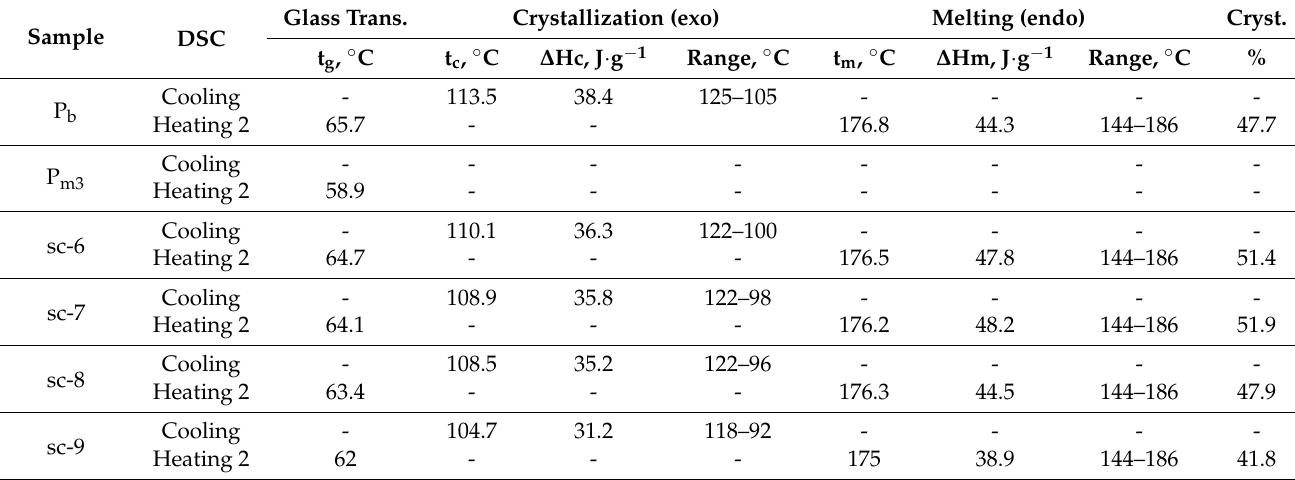
Table 5. DSC behavior of the sc-6, sc-7, sc-8 and sc-9 compounds and of the blended PLA grades (P b and P m3 ).